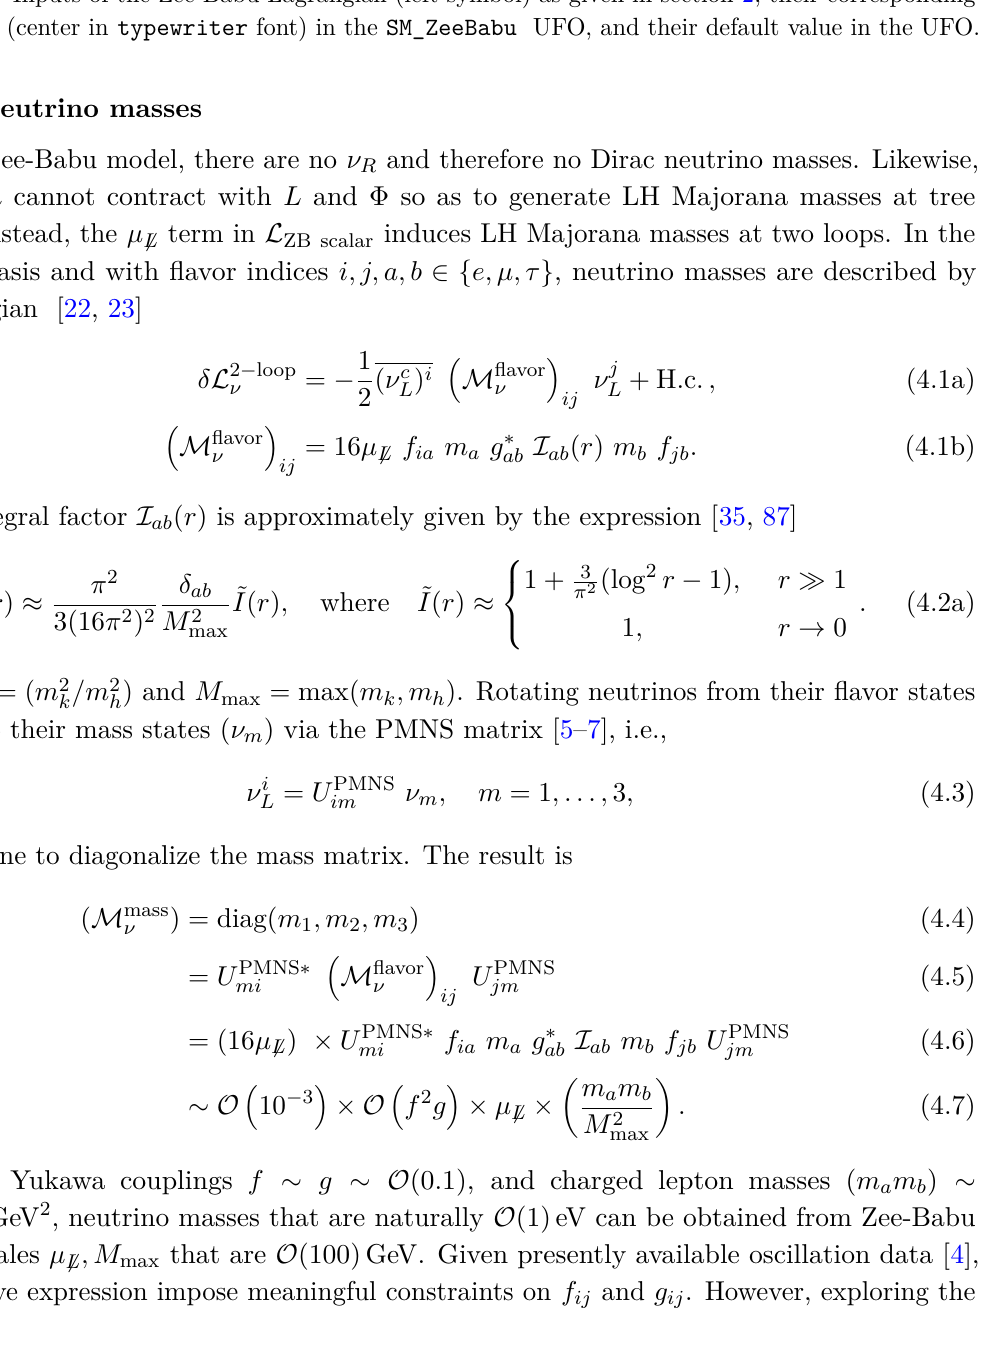
Table 1 . Inputs of the Zee-Babu Lagrangian (left symbol) as given in section 2, their